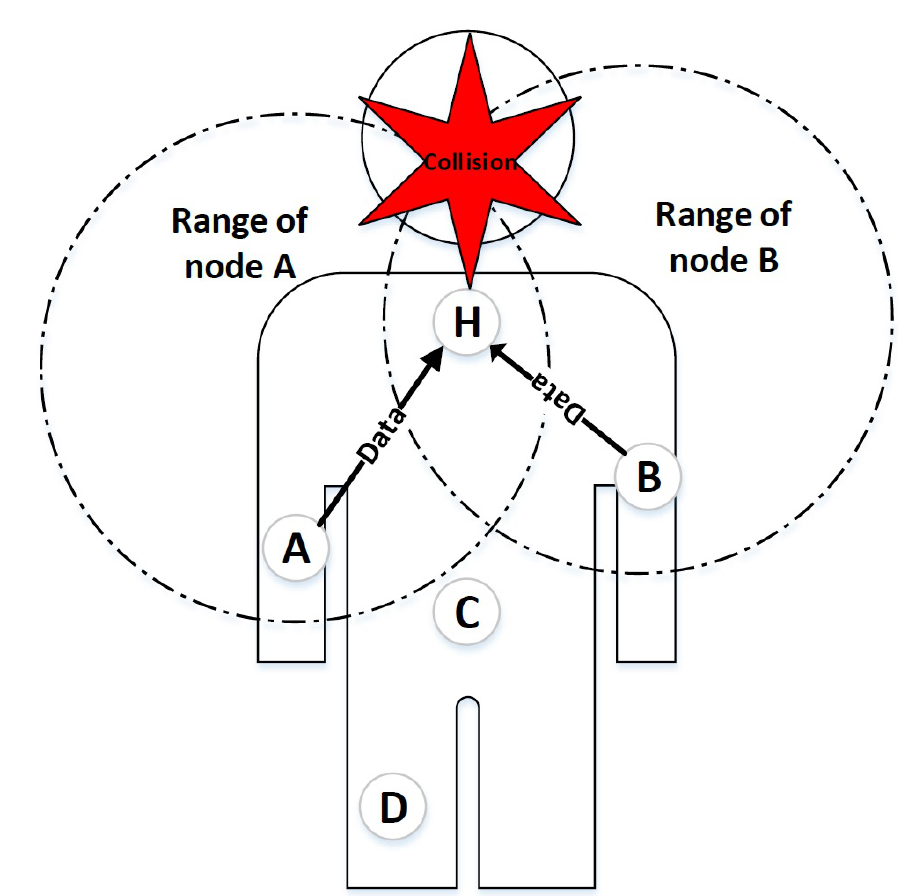
Figure 1. Hidden node problem in a single-hop IEEE 802.15.6 Carrier Sense Multiple Access with Collision Avoidance (CSMA/CA) based